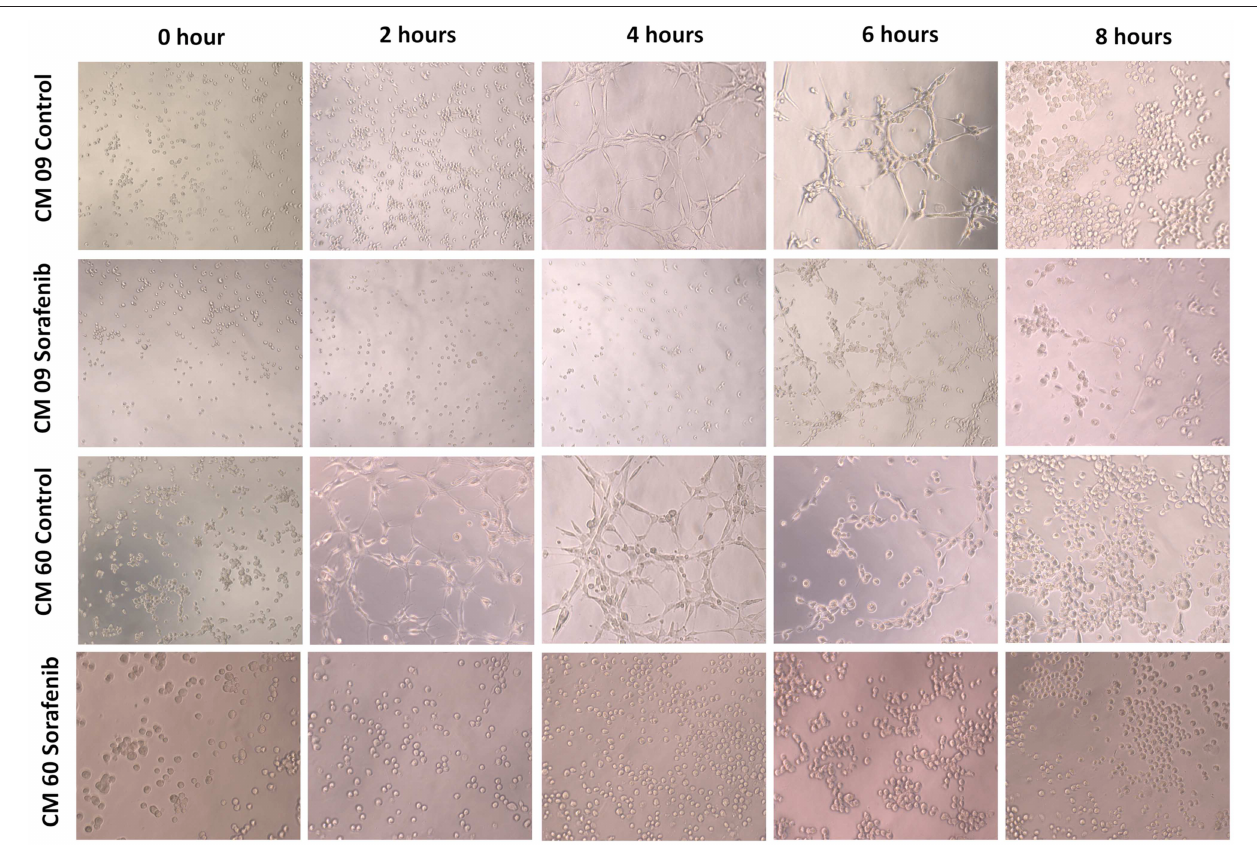
FIGURE 4 | Evaluation of in vitro vasculogenic mimicry by two canine mammary gland tumor cell lines (CM9 and CM60). It was possible to observe tubular-like structures in both cell lines after 4h. After 6h, both cell lines started to show tubule disruption, and a group of cells had formed at 8h. The cells treated with sorafenib showed no tubular-like structure formation at 4h. Additionally, at 6h, the sorafenib-treated cells had not formed linked tubular